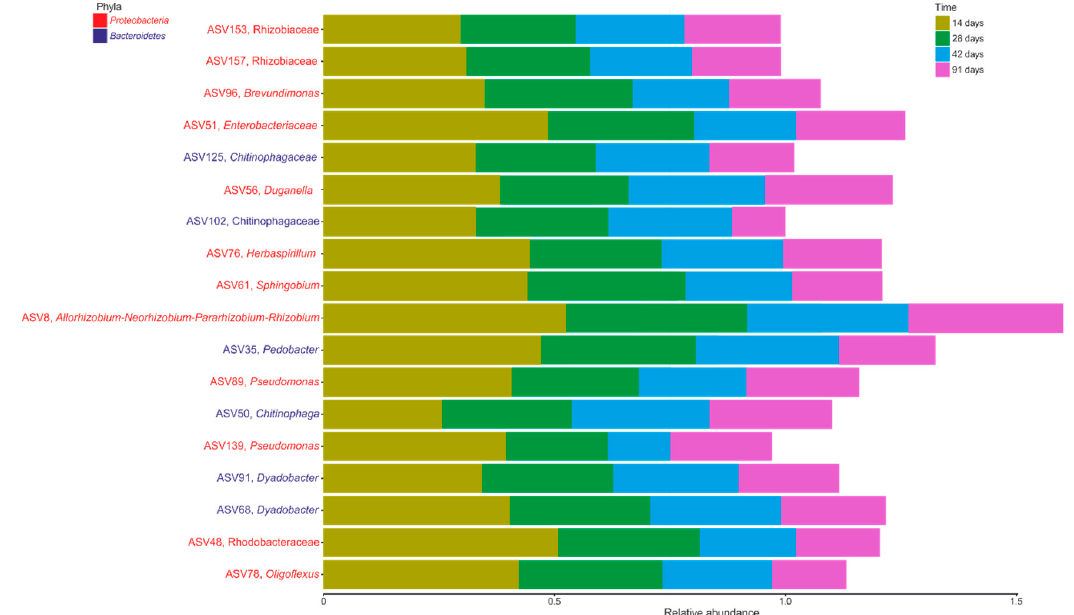
Figure 4. Relative abundance (%) of ASVs (phylum and genus or most inclusive taxonomy found) from the core microbiome of vermicomposting of grape marc derived from the red winemaking process of the grape variety Mencía across days 14, 28, 42, and 91.